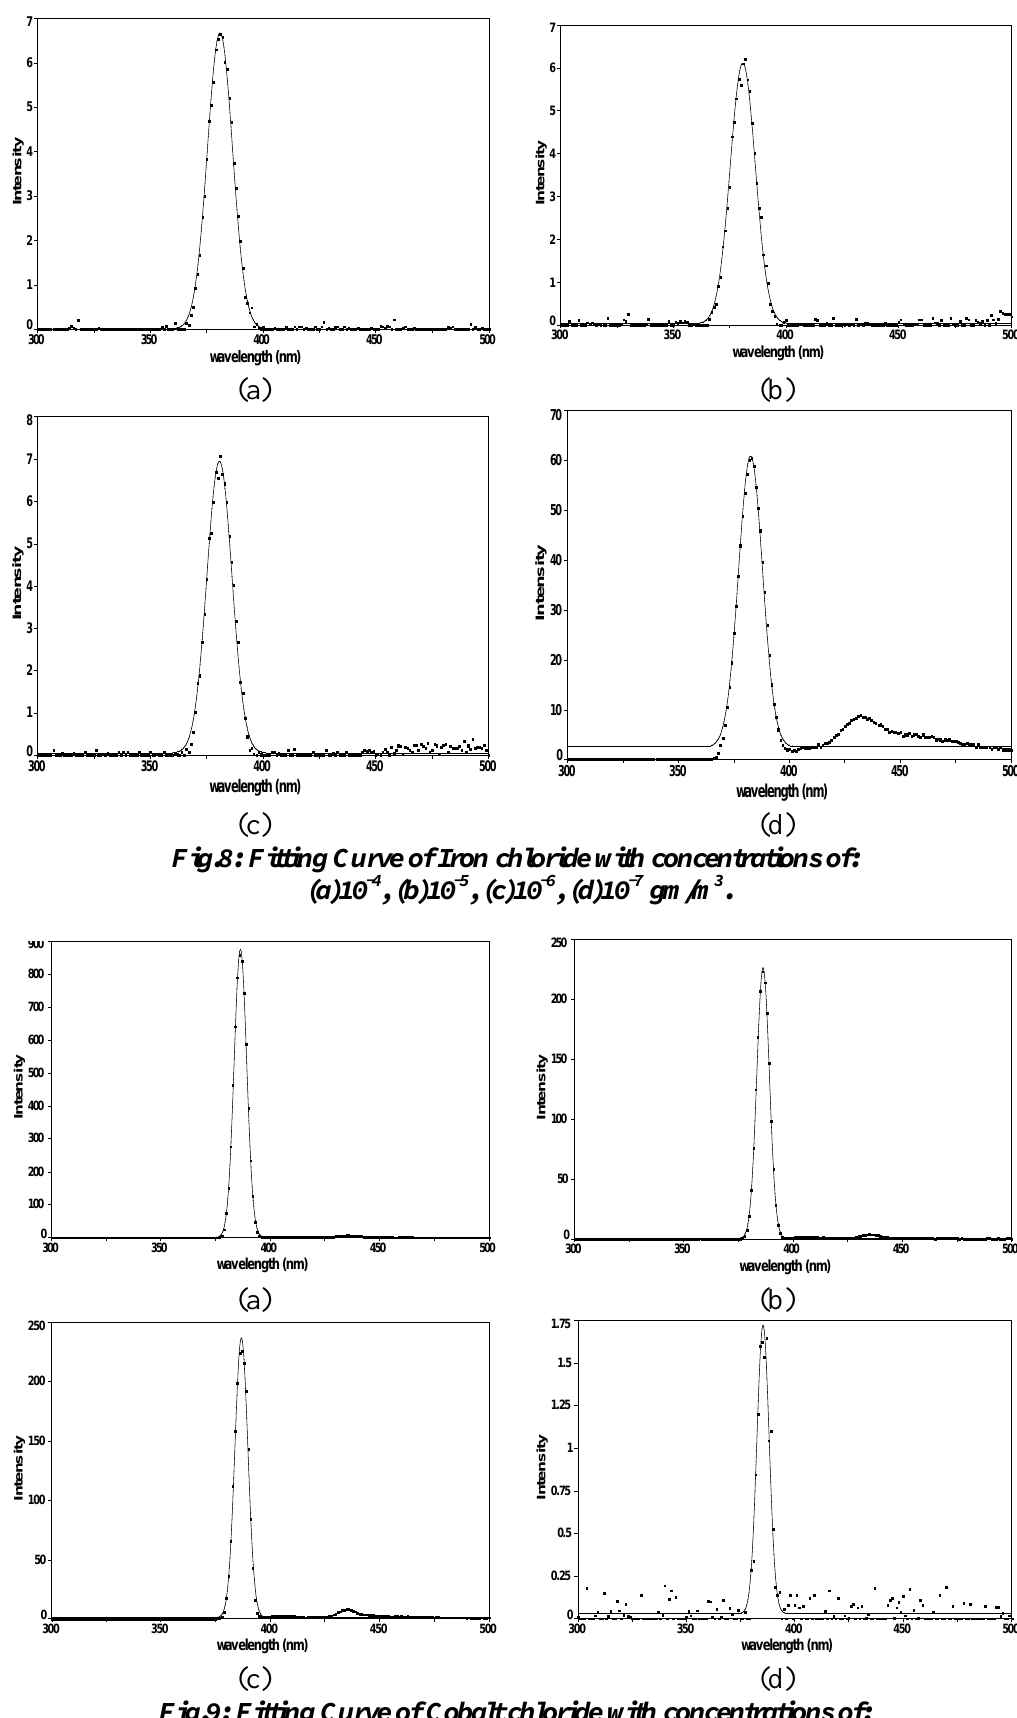
Fig.9: Fitting Curve of Cobalt chloride with concentrations